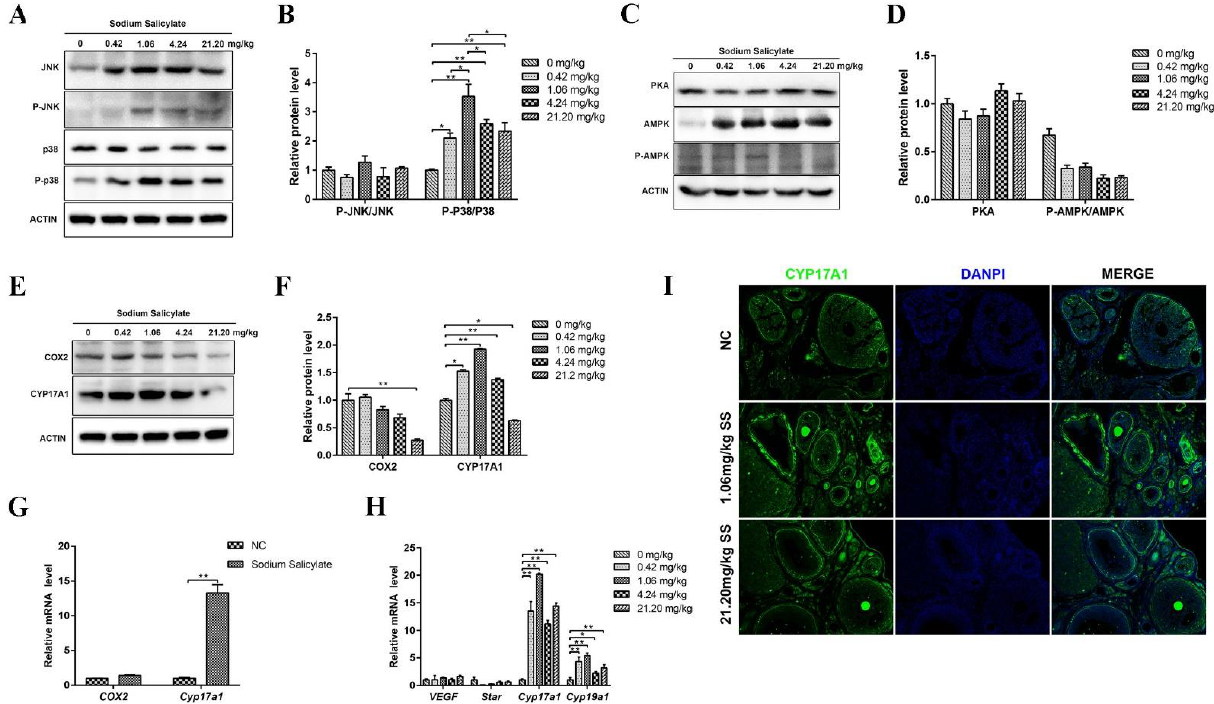
Figure 4. Effects of sodium salicylate on related pathways. ( A , B ) Changes in JNK, P-JNK, p38, and P-p38 protein levels in the sodium salicylate (SS)-treated group. ( C , D ) Expression of PKA and AMPK pathway-related proteins in the ovaries of mice treated with sodium salicylate (SS) treatment. ( E – G ) The protein ( E , F ) and mRNA levels ( G ) of COX2 and CYP17A1 were measured in the ovaries of mice in the different treatment groups. ( H ) mRNA expression of VEGF , Star , Cyp17a1 , and Cyp19a1 , which regulate ovulation, in the granulosa cells of mice treated with sodium salicylate. ( I ) Immunofluorescence results of CYP17A1 in ovarian tissue sections. * p < 0.05, ** p < 0.01.